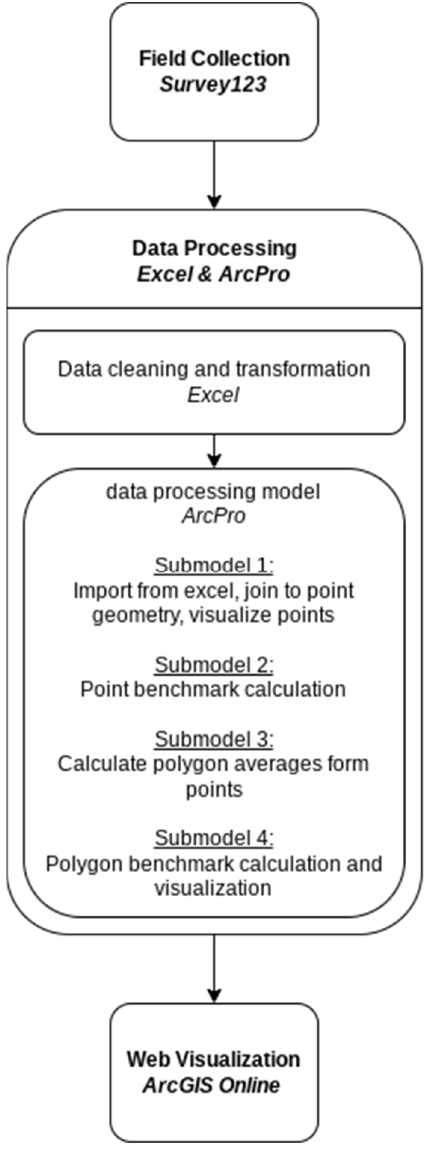
Figure 2. The workflow and software used in the GMMT. The data processing model and submodels were created in ModelBuilder within ArcPro.